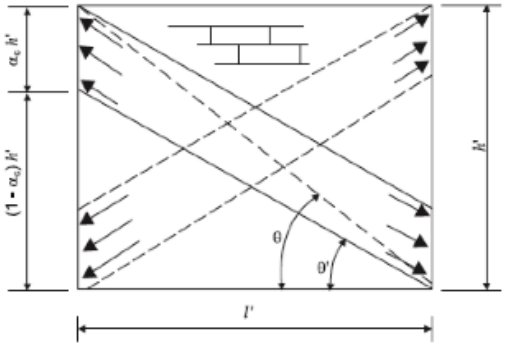
Figure 5. Strut model column-to-column (adapted from Ref.